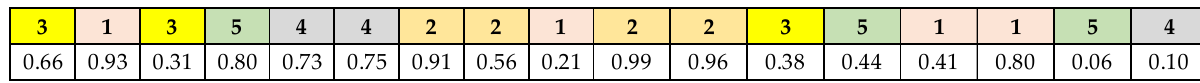
Figure 9. Repair mechanism.